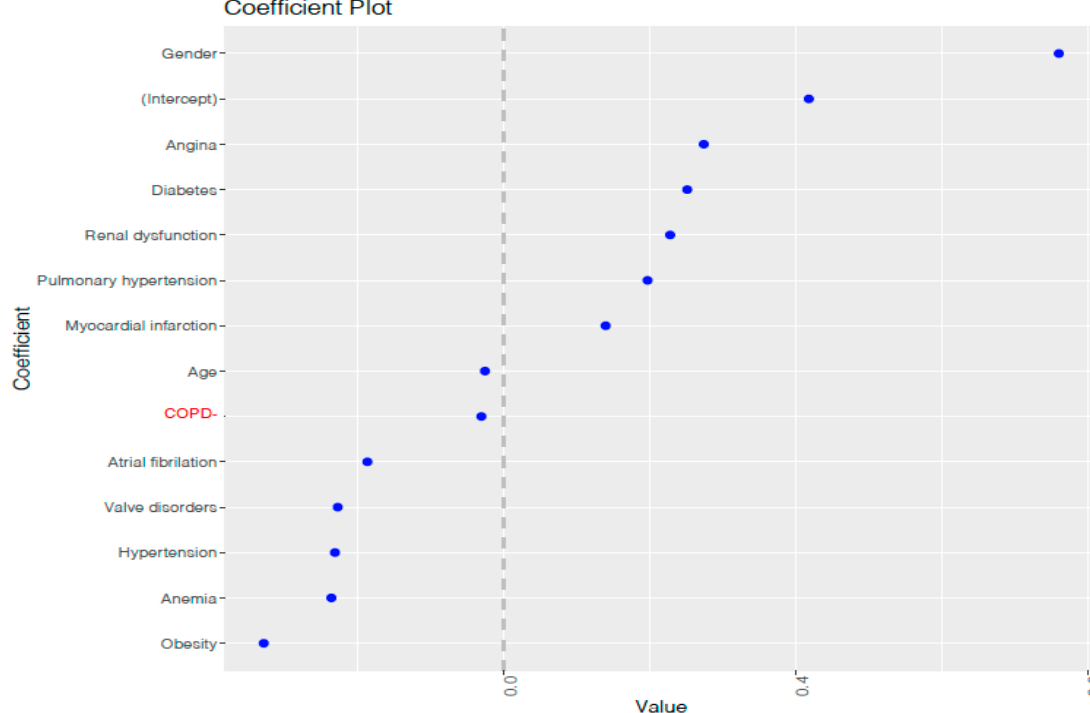
Figure 4. Coefficients’ values fixing λ = λ min in the LASSO model. The up and down positions on the y -axis show the variables which most contribute to the model as its associated coefficients take the highest values in the training set . On the middle positions, the variables which contribute less to the model are located, as its associated coefficients are close to 0.